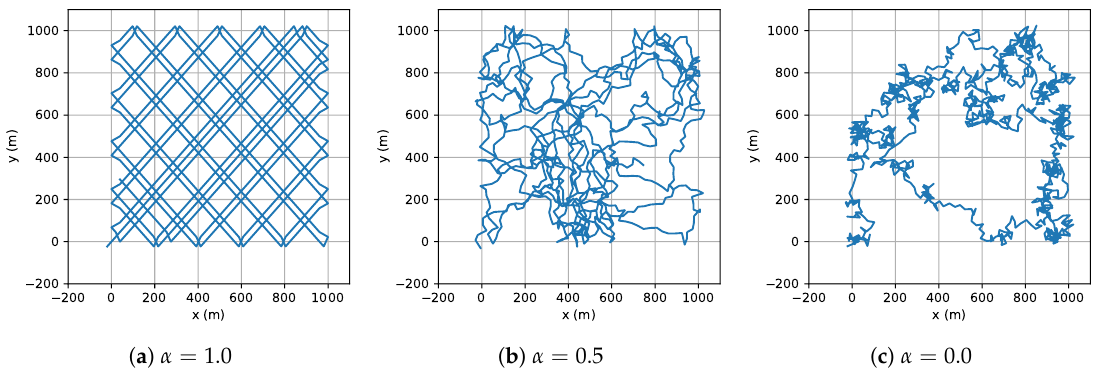
Figure 3. An example of user movement in the GM mobility model at different values of the tuning parameter α